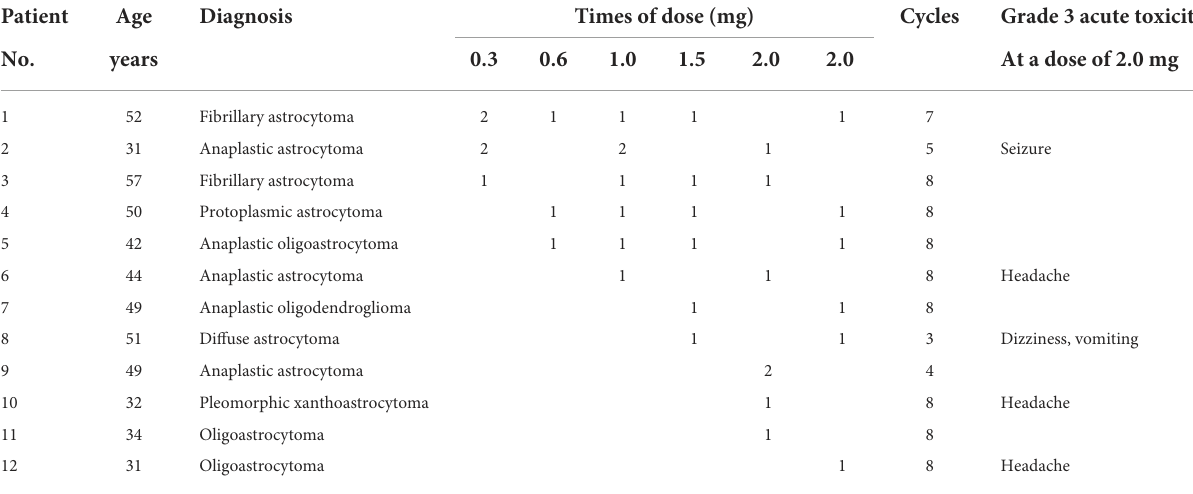
TABLE 2 Dose administered and grade 3 acute toxicity occurring in phase I